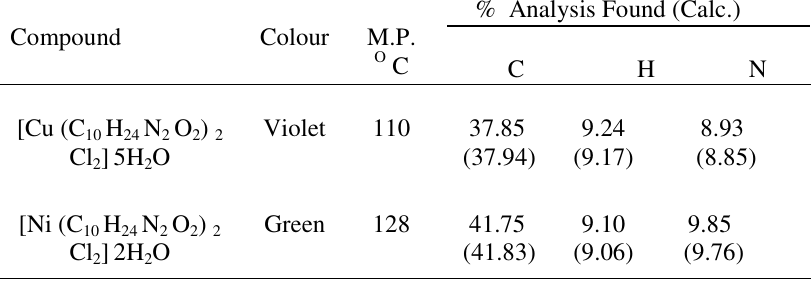
Table 1 . Physical properties and analytical data of metal complexes of